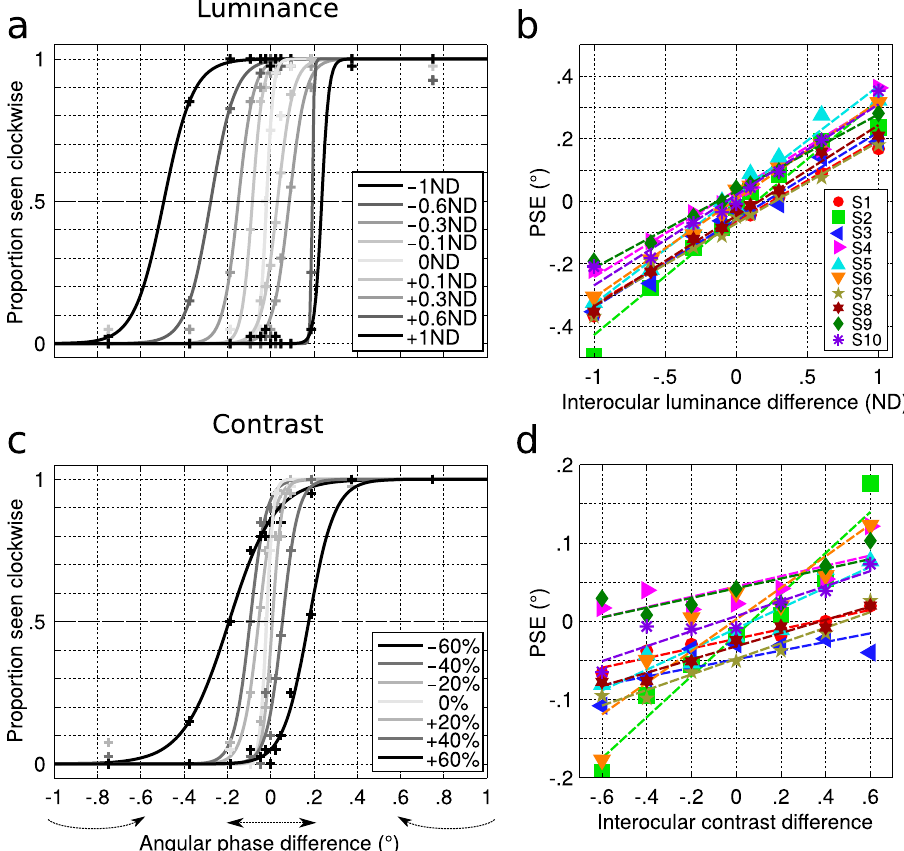
Figure 2. Results. ( a ) Psychometric functions of the perceived direction of rotation for one subject (S2) as a function of the interocular phase difference for different luminance conditions. Negative ND value: indicates filter is placed in front of the left eye, positive: filter placed in front of the right eye. Datapoints are fitted by a logistic function. The midpoint of the logistic function at 0.5 performance defines the point of subjective equality (PSE). ( b ) PSE as a function of the interocular luminance difference for the individual 10 subjects. Dashed lines represent linear regression. ( c ) Psychometric functions of the perceived direction of rotation for the same subject as a function of the interocular phase difference for different contrast conditions. Negative contrast value: contrast decreased in the left eye image, positive: contrast decreased in the right eye image. ( d ) PSE as a function of the interocular contrast difference for the individual 10